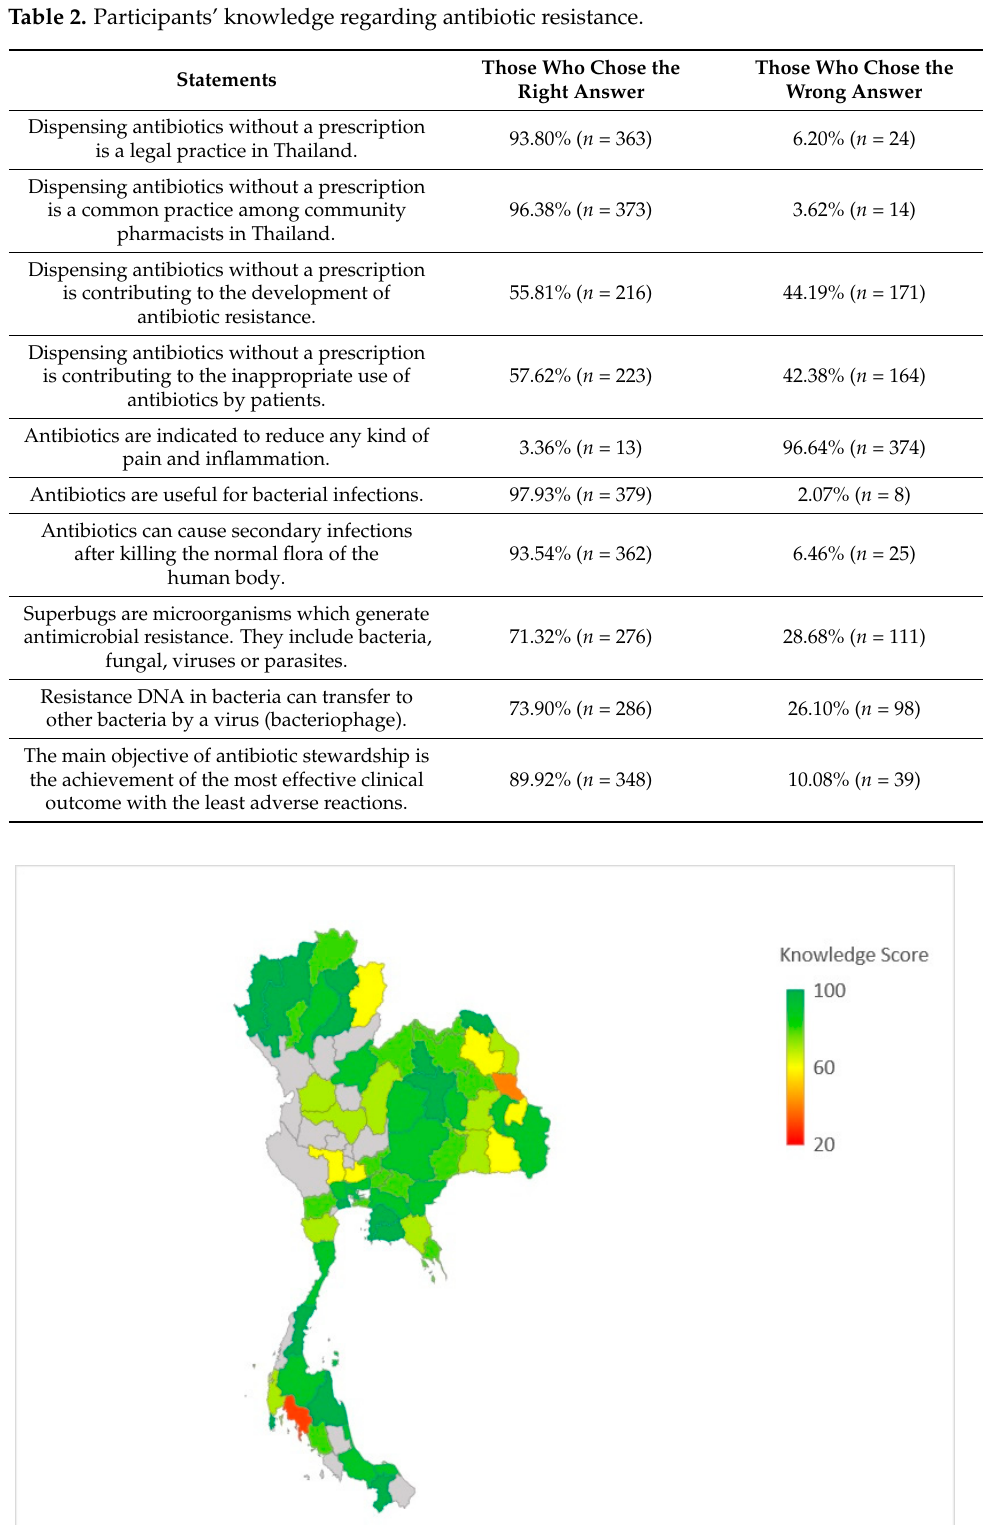
Figure 1. Graphical representation of participants’ Knowledge scores in the study (Powered by Bing ©GeoNames, Microsoft,